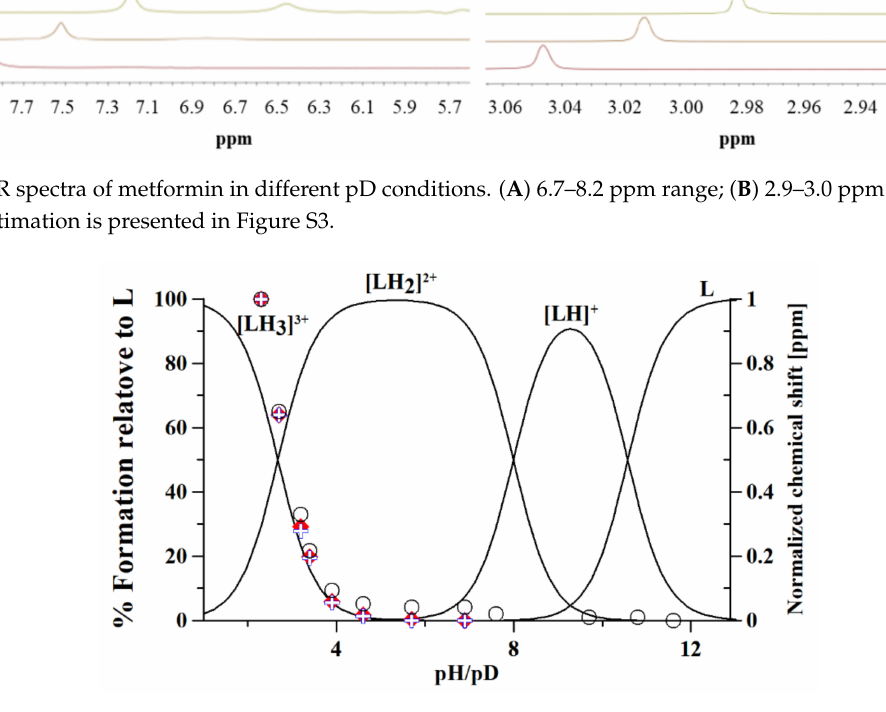
Figure 2. Speciation plot of metformin (L), calculated on the basis of protonation constants reported in Table 1. The normalized chemical shifts of each proton overlap the speciation plots: (-NH) + and (cid:7) ; (-CH ; protons (Scheme 3 ) (cid:35)